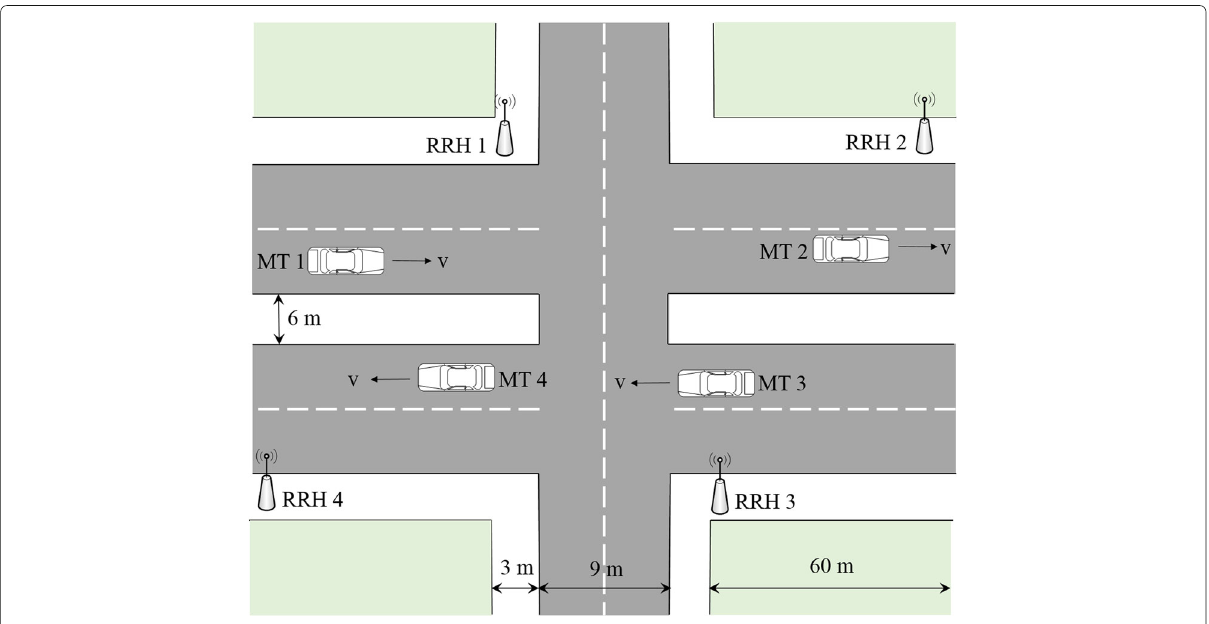
Fig. 4 The simulation scenario; each RRH serves one mobile terminal (MT)